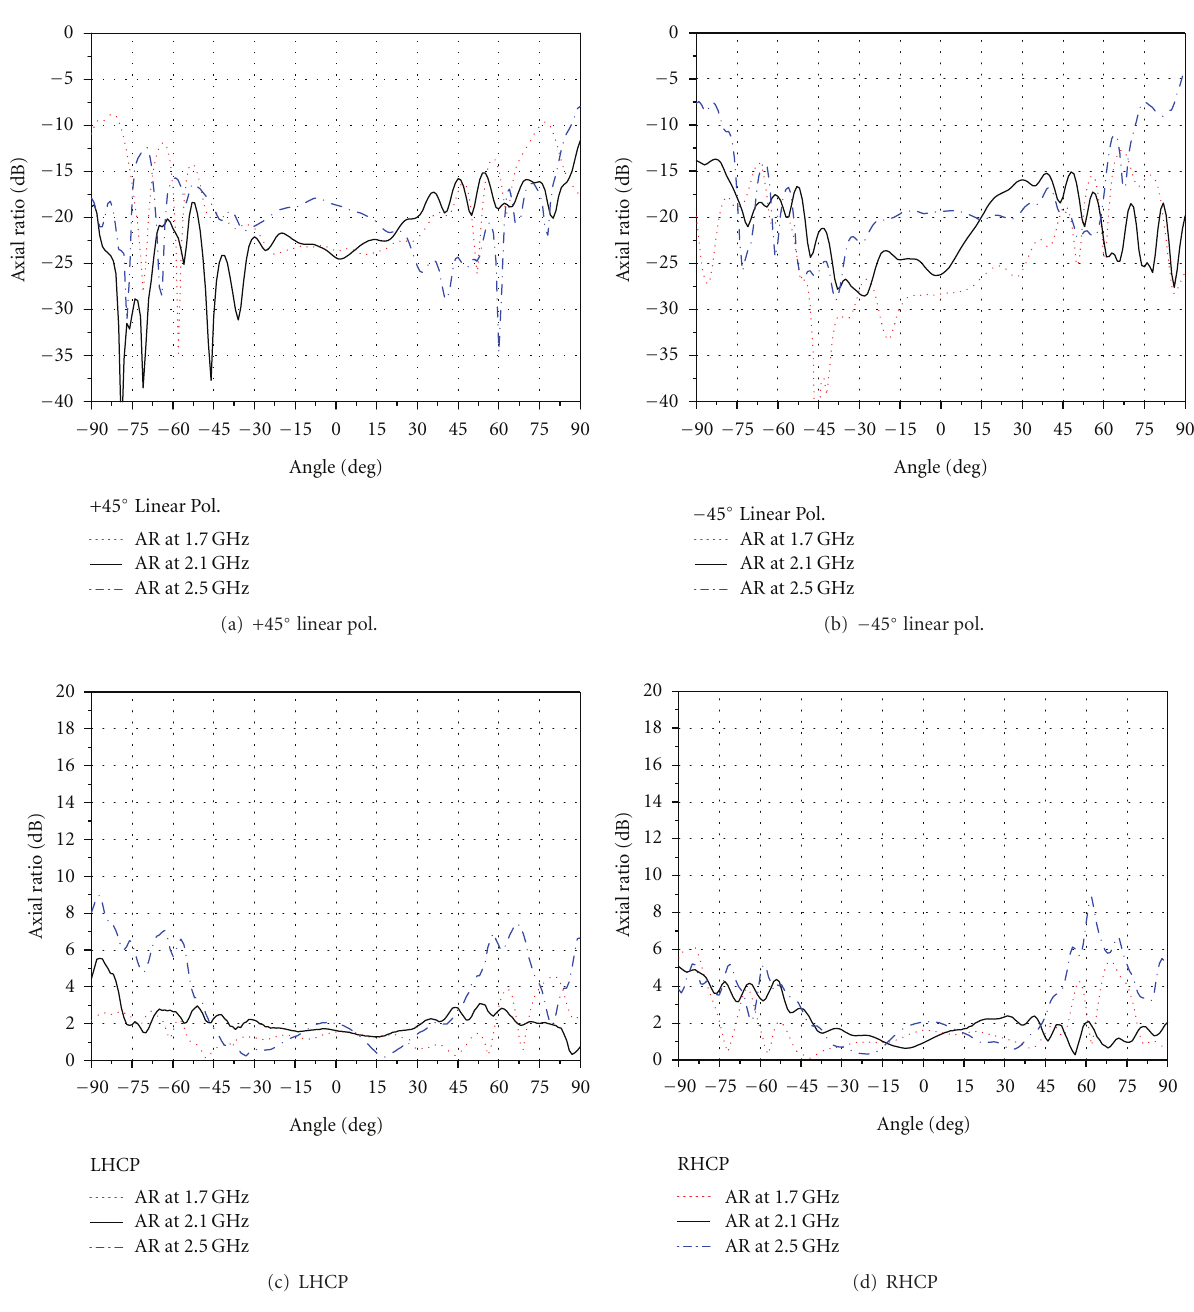
Figure 12: Measured axial ratios of the BPCDE PR